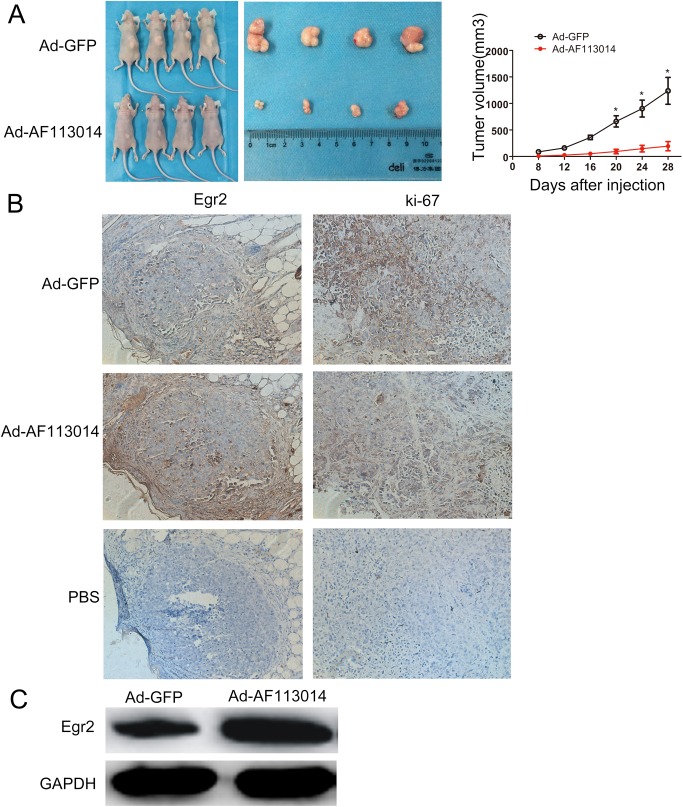
AF113014 influenced tumor growth in vivo.(A) Representative tumors formed in Ad-GFP and Ad-AF113014 infected SMMC7721 cells, and the tumor growth curve of each group. * P < 0.05, ** P < 0.01. (B) Transplanted tumors sections were stained with Egr2 and Ki-67. (C) Western blot analysis of Egr2 expression in transplanted tumors. GAPDH was used as control.